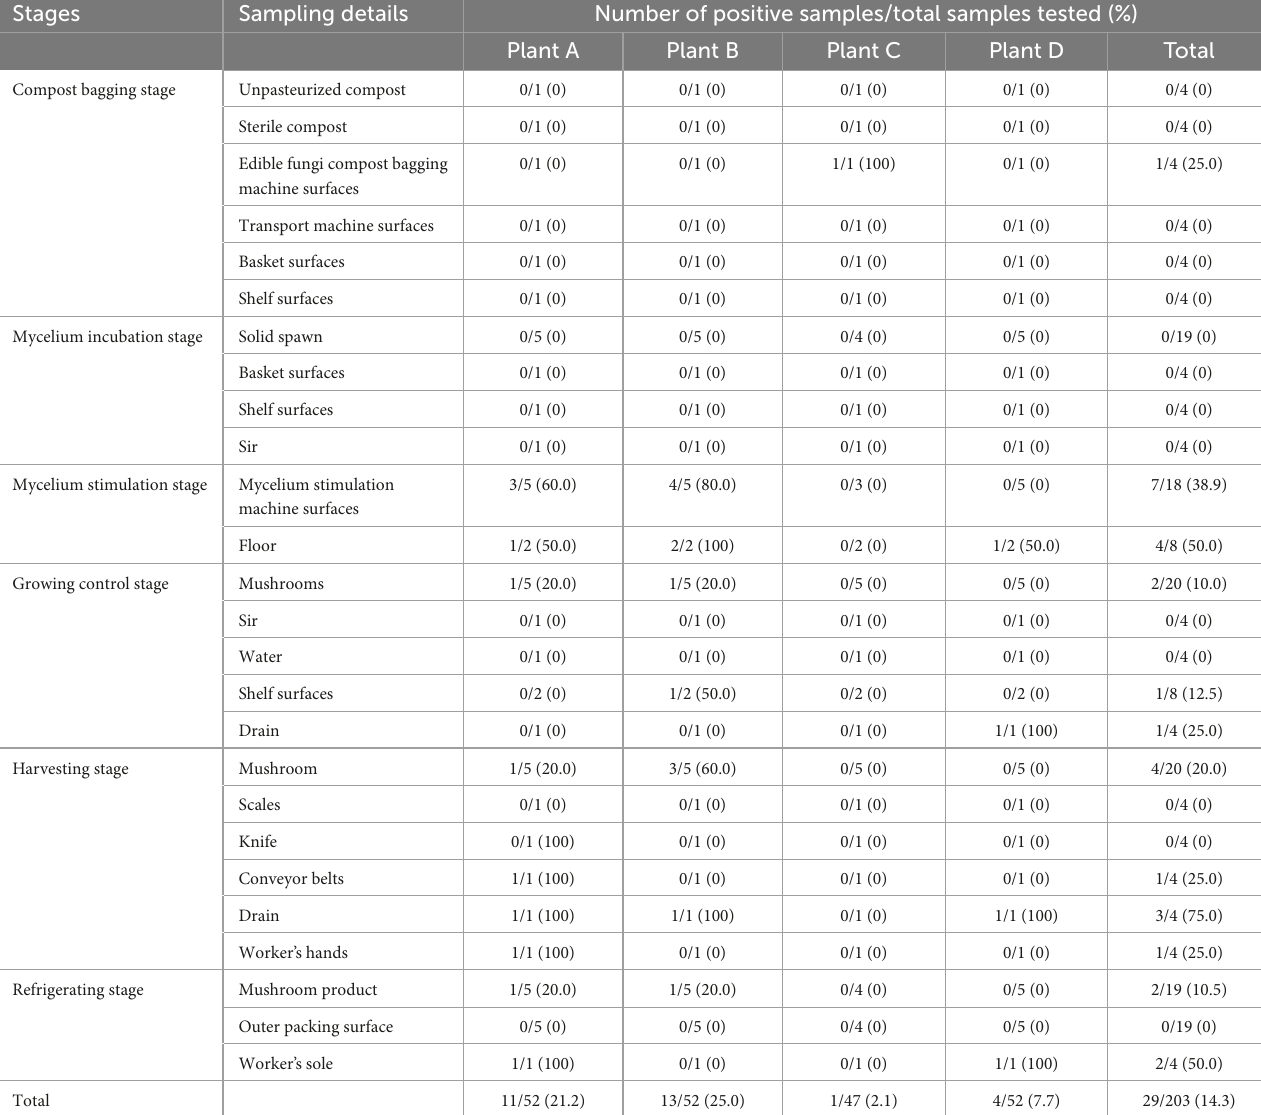
TABLE 1 Prevalence of Listeria monocytogenes in Pleurotus eryngii production